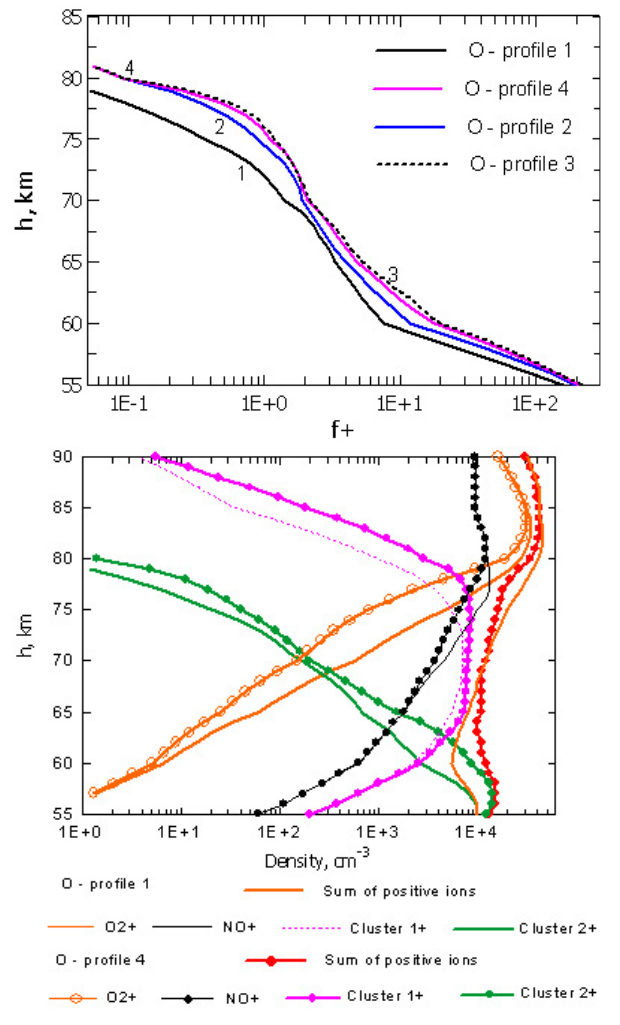
Fig. 4. Upper panel: Profiles of positive ions based on O-profiles 1 and 4 for 17 January 2005 at 09:50UT. Lower panel: f + (h) - profiles based on O-profiles 1–4 for 17 January 2005 at 09:50UT.